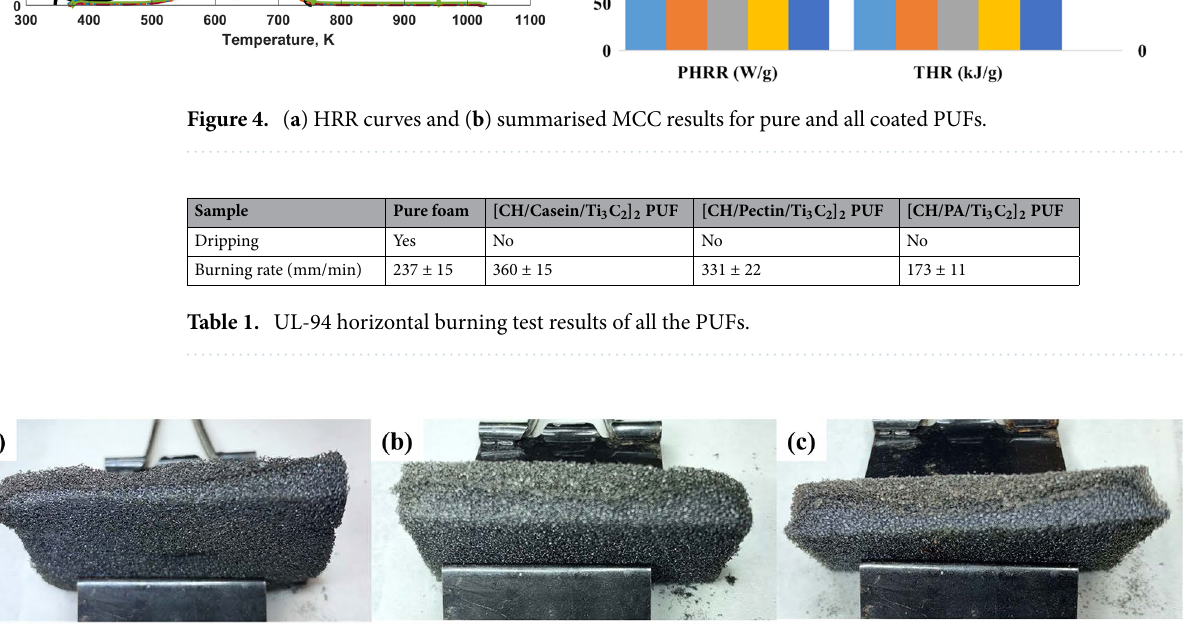
Figure 5. Cross-section digital images of UL-94 horizontal burning testing residues of ( a ) [CH/Casein/Ti 3 C 2 ] 2 , ( b ) [CH/Pectin/Ti 3 C 2 ] 2 , and ( c ) [CH/PA/Ti 3 C 2 ] 2 coated